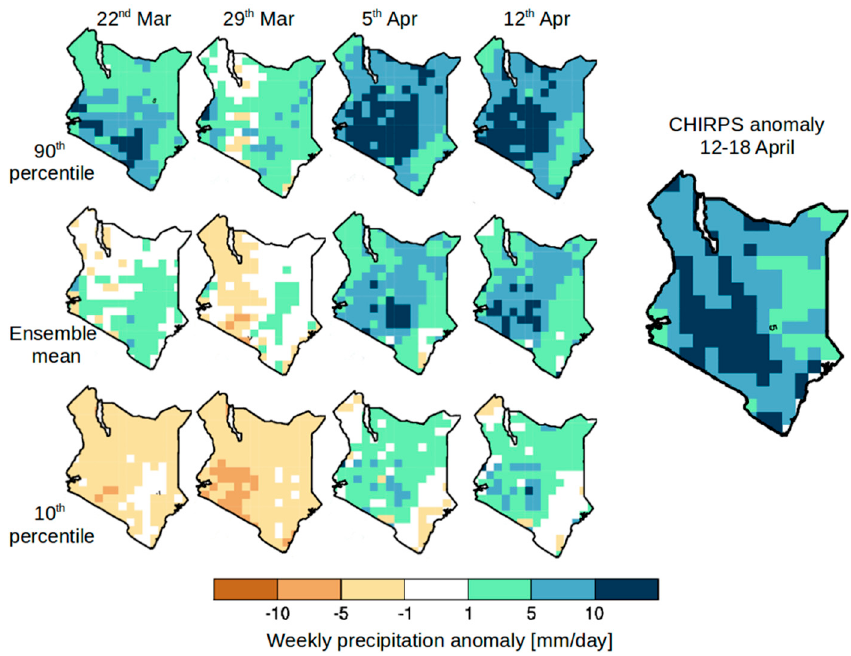
Figure 13. As Figure 12, but for the forecast target week 12–18 April.